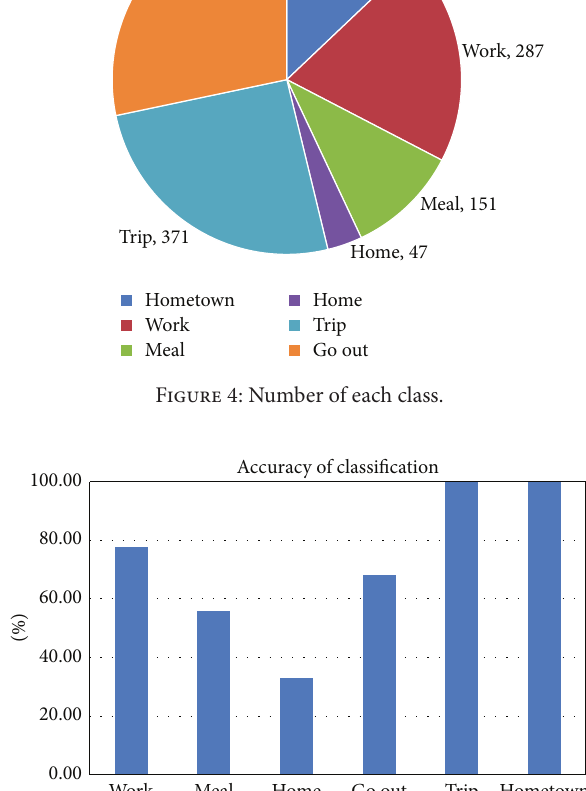
RBF neural network. The accuracy of SVM is 77.59%, and the accuracy of RBF neural network is 71.72%. Based on the results, the accuracy of SVM is higher. So we choose to analyze the result of SVM classification result. As shown in Figure 5, the accuracy of “trip” and “hometown” is 100%.